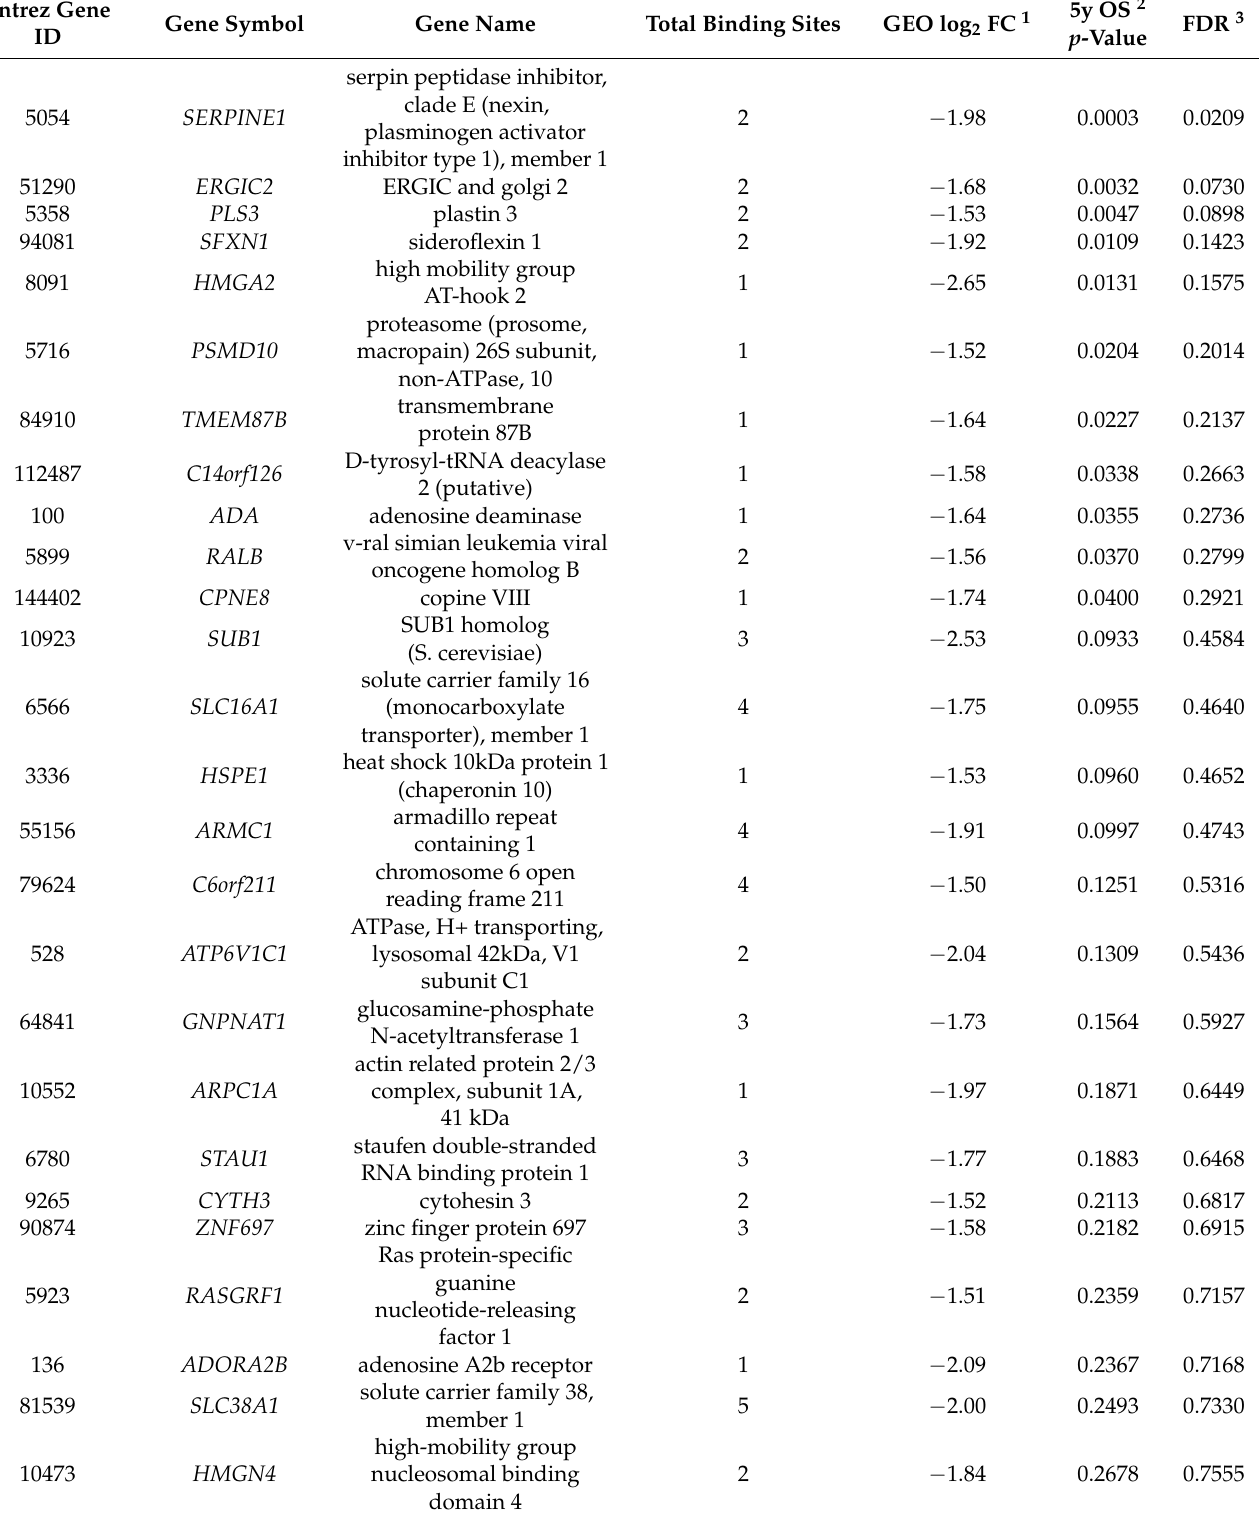
Table 1. Upregulated genes in HNSCC clinical specimens in TCGA-HNSC database